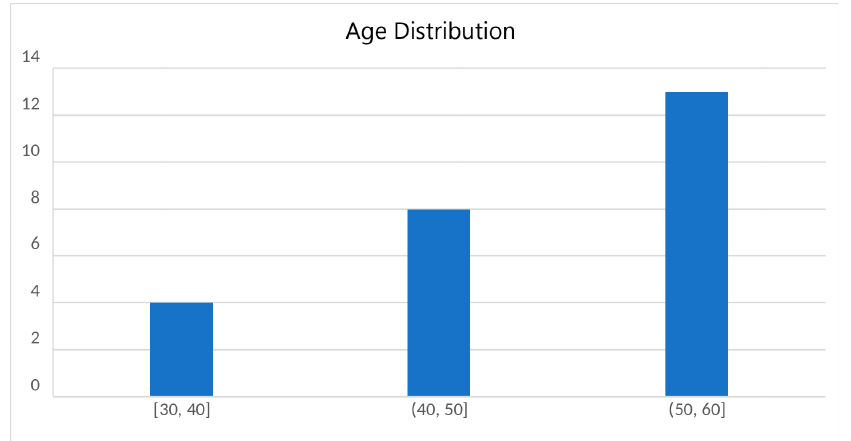
Figure 12. Participants’ age distribution.